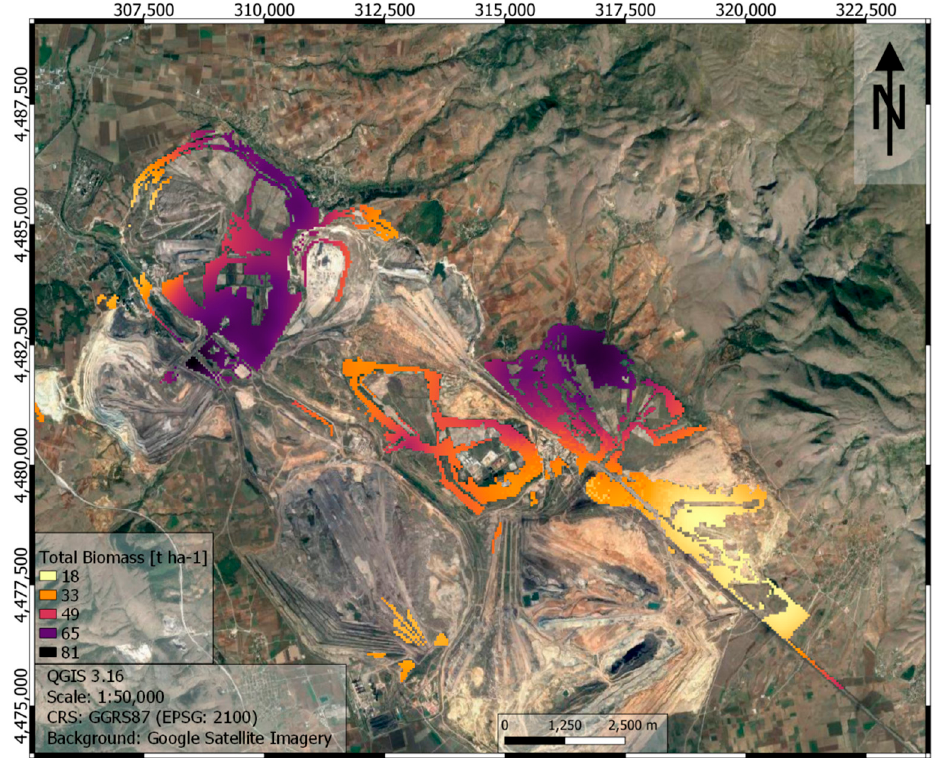
Figure 6. Aboveground biomass distribution map at Ptolemaida mining area. Coordinates in the Hellenic Geodetic Reference System (HGSA 87).